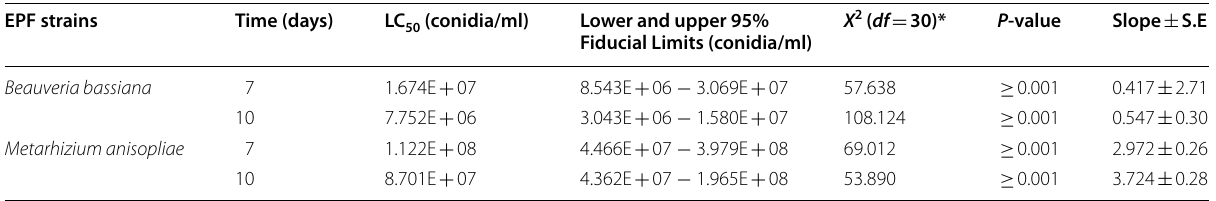
Table 3 Median lethal concentration (LC ) values for the indigenous strains of entomopathogenic fungi Beauveria bassiana and 50 Metarhizium anisopliae bioassayed against late 3rd instar nymphs of peach-potato aphid Myzus persicae under laboratory conditions